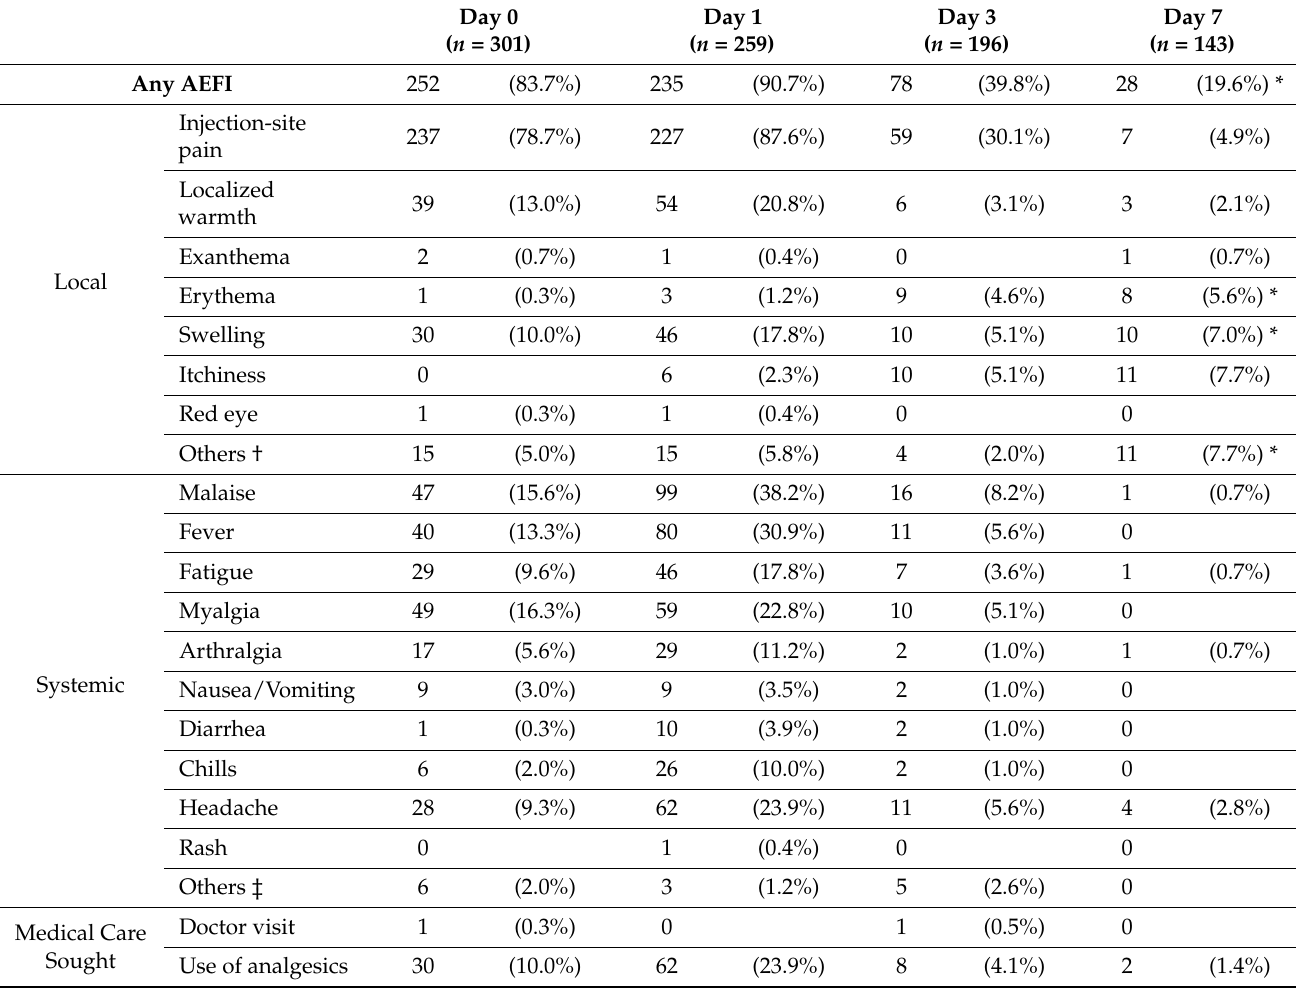
Table 2. Adverse events following immunization (AEFIs) for the first dose. AEFIs: adverse events following immunization. * Fisher’s exact test, significantly higher ( p < 0.05) than the second dose (Table 3). † Other local AEFIs include numbness, sore throat, eye irritation, and others. ‡ Other systemic AEFIs include irregular bleeding, anorexia, cerebral anemia, and others. Day 0 is defined as the day of